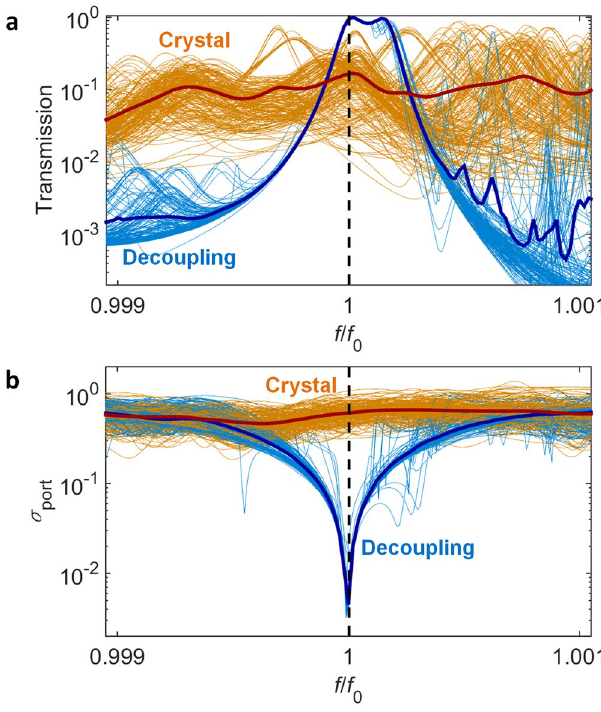
Figure 4. Statistical spectral analysis of eigenstate decoupling. ( a ) Transmission and ( b ) amplitude fluctuation spectra for the decoupling system (light blue thin lines) and the ordinary crystal system (orange thin lines), for the ensemble of 2 9 samples. The fluctuation σ port in ( b ) is the standard deviation of output field amplitude for 11 ports, normalized by the averaged amplitude ( σ port = 0 for ideal planewave). Blue and red thick lines in ( a,b ) denote the averaged results for 2 9 samples of each system. Black dashed line depicts the design frequency.